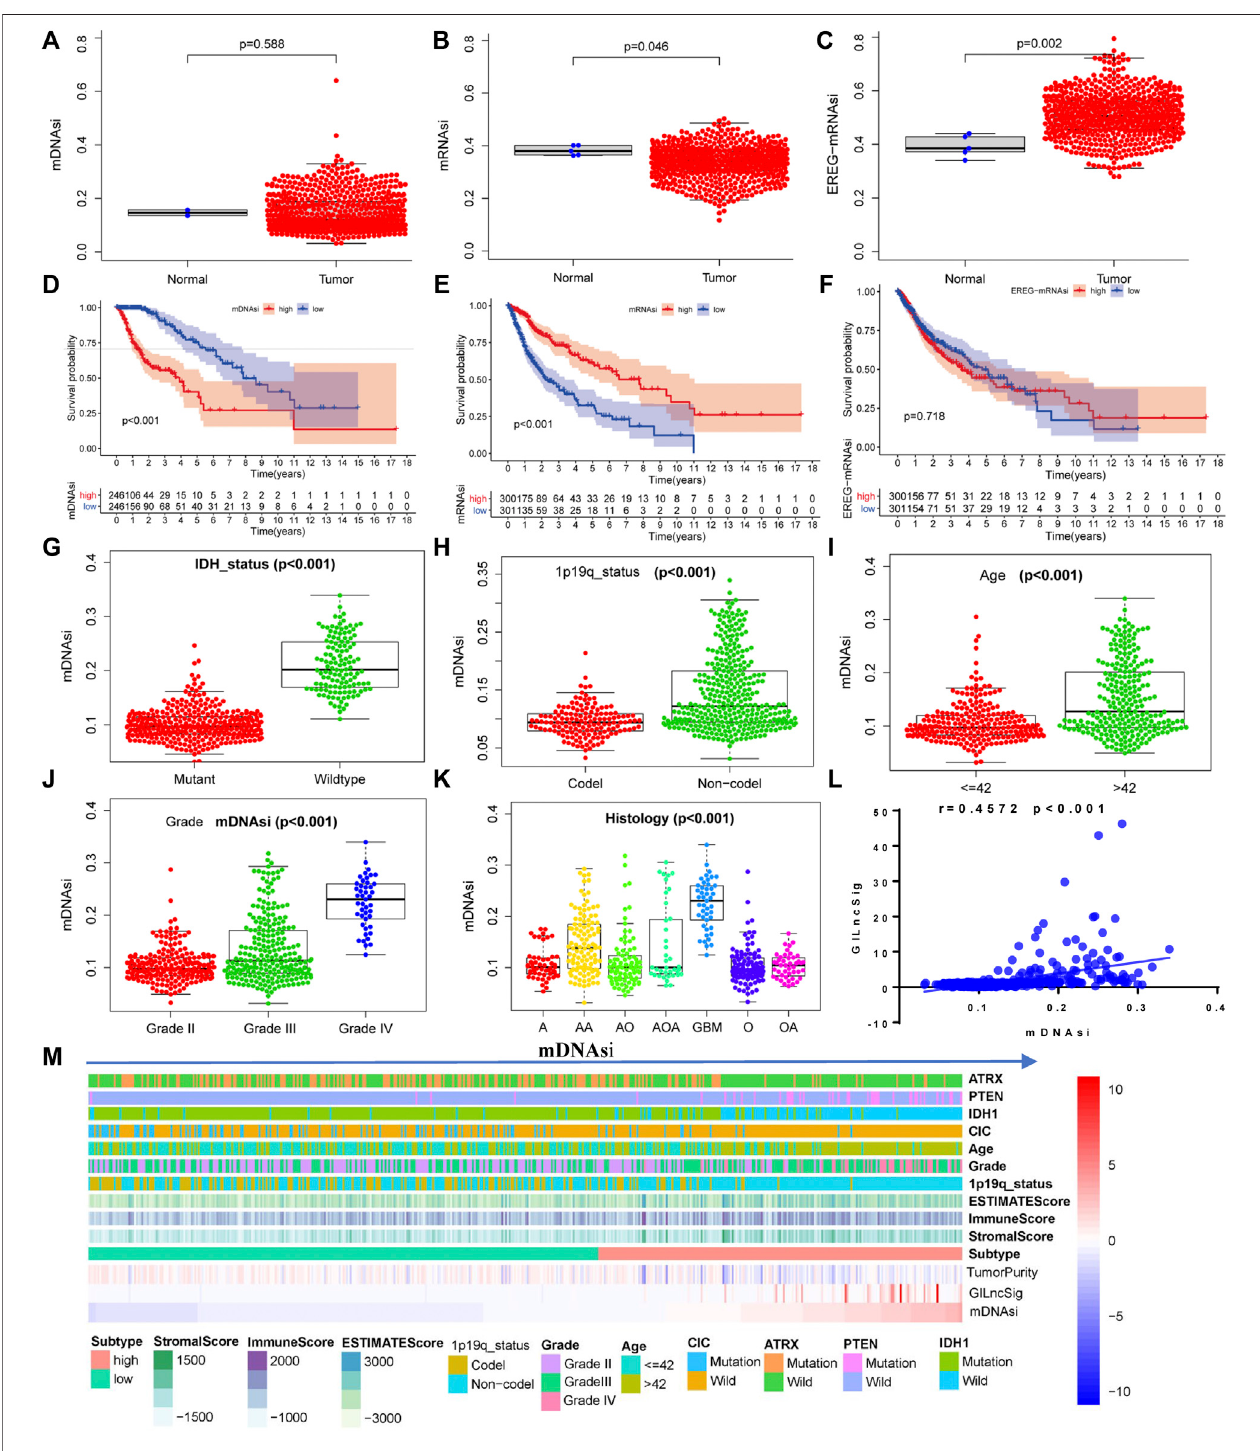
FIGURE 9 | Relationship between the stemness index of glioma cells and GILncSig. Expression of glioma cell stemness indicators in glioma samples and normal tissues:mDNAsi (A) ,mRNAsi (B) ,andEGFR-mRNAsi (C) .Relationshipbetweenthegliomacellstemnessindexandoverallsurvivalofpatients:mDNAsi (D) ,mRNAsi (E) , and EGFR-mRNAsi (F) . Distribution of the mDNAsi index in patients with different clinical symptoms of glioma: IDH status (G) , 1p19q status (H) , patient age (I) , WHO grade (J) , and histology (K) . (L) Pearson correlation analysis of the GILncSig score and the mDNAsi index. (M) Heatmap of glioma immune microenvironment based on the mDNAsi